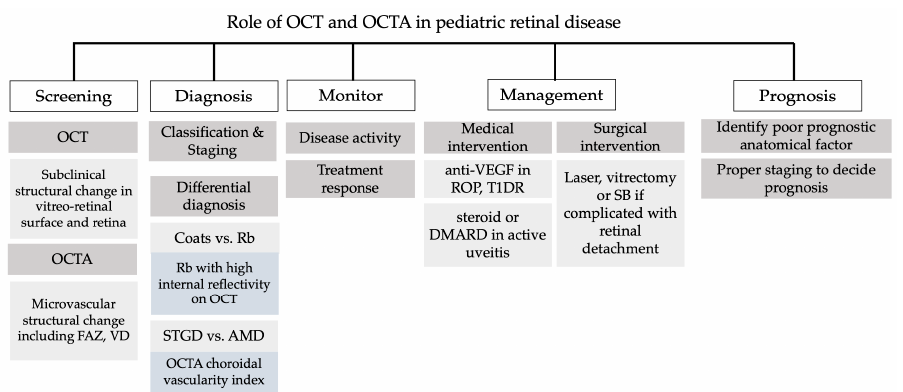
Figure 4. Proposed flowchart for OCT and OCTA in pediatric retinal disease. Abbreviations—OCT: optical coherence tomography, OCTA: optical coherence tomography angiography, Rb: retinoblastoma, STGD: Stargardt disease, AMD: age-related macular degeneration, VEGF: vascular endothelial growth factor, ROP: retinopathy of prematurity, T1DR: type 1 diabetic retinopathy, DMARD: disease-modifying anti-rheumatic drugs, SB: scleral buckle.